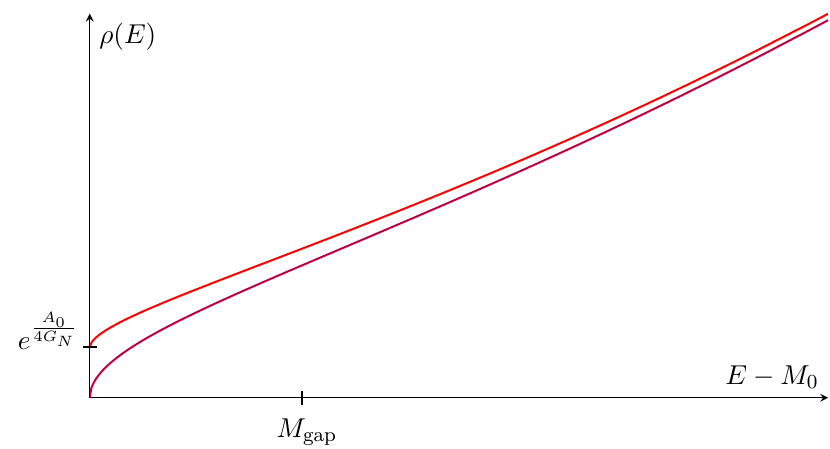
Figure 2. Purple: density of states (at fixed charge) for black holes states as a function of energy above extremality E − M , including backreaction effects given in (3.26). Red: plot of the naive 0 density of states ρ ∼ exp ( A 4 G ) which starts deviating from the full answer below energies of hor / N order M gap